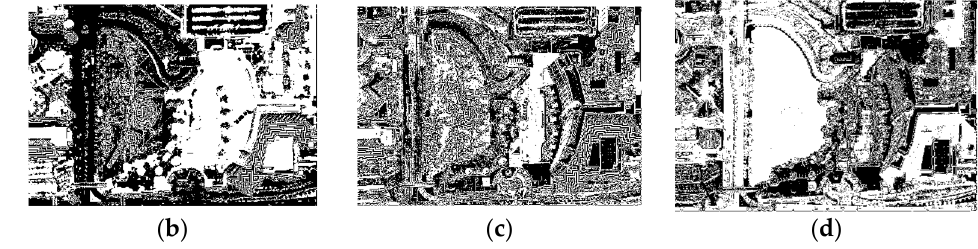
Figure 10. Segmentation results of GeoEye-1 satellite remote sensing image 3: ( a ) original remote sensing image; ( b ) TPSCA–PCNN segmentation result; ( c ) PCNN segmentation result; ( d ) ELM segmentation result.